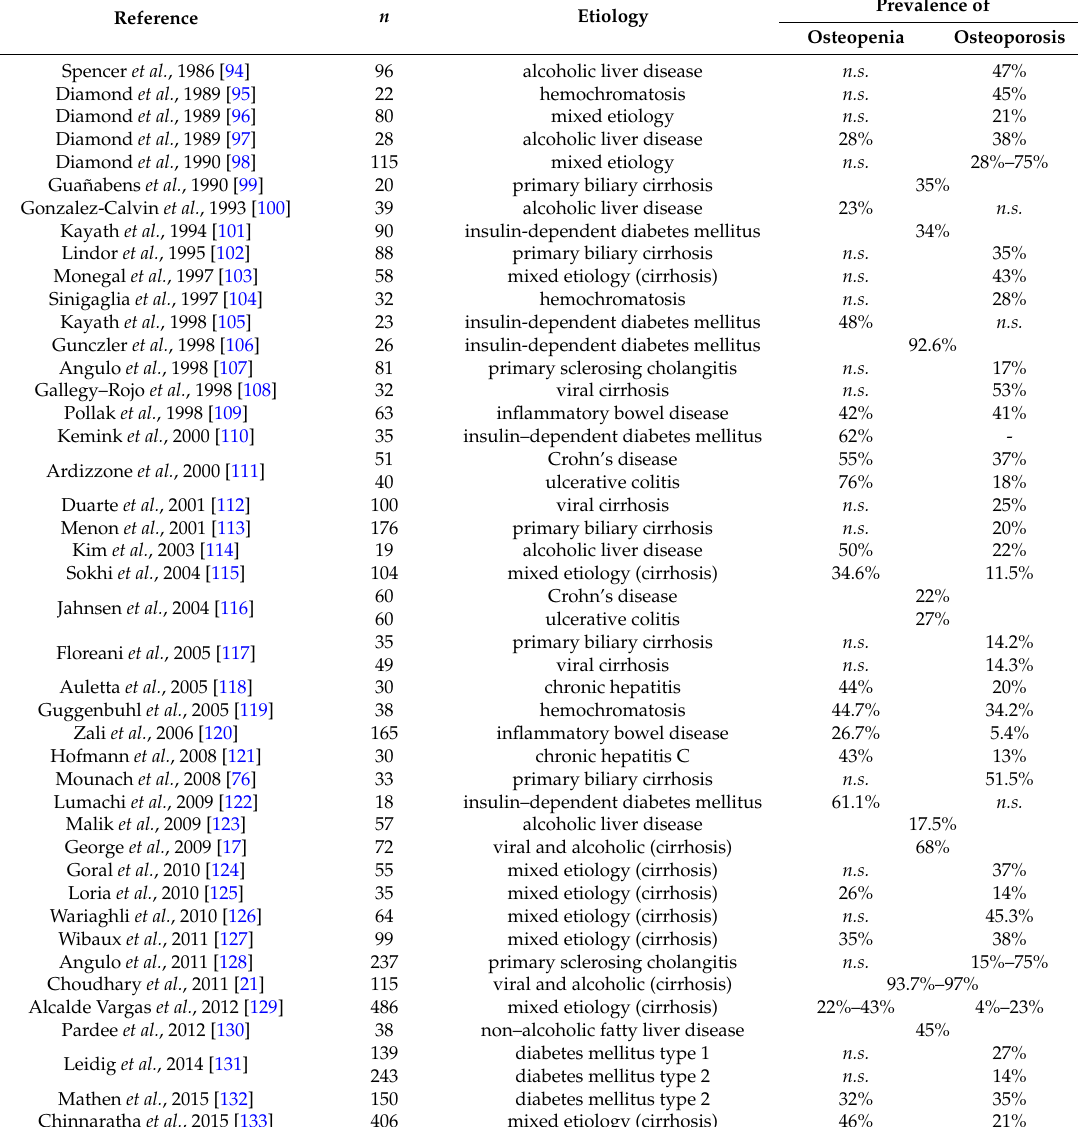
Table 1. Prevalence and degree of bone disease related to chronic diseases of various